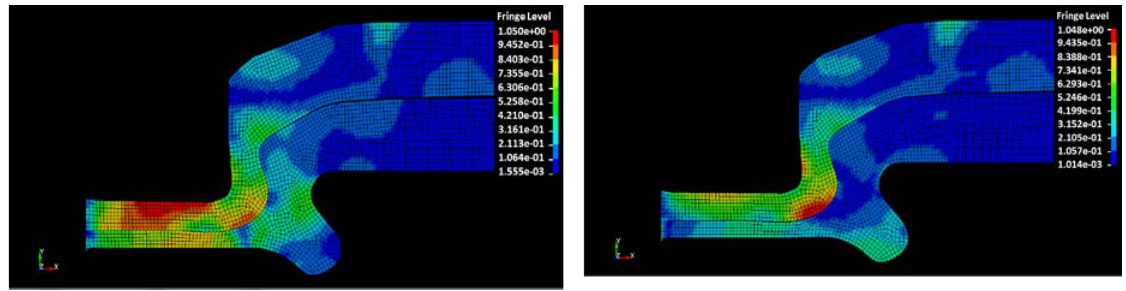
Figure 5: Final shape of the joint before and after stress release (springback